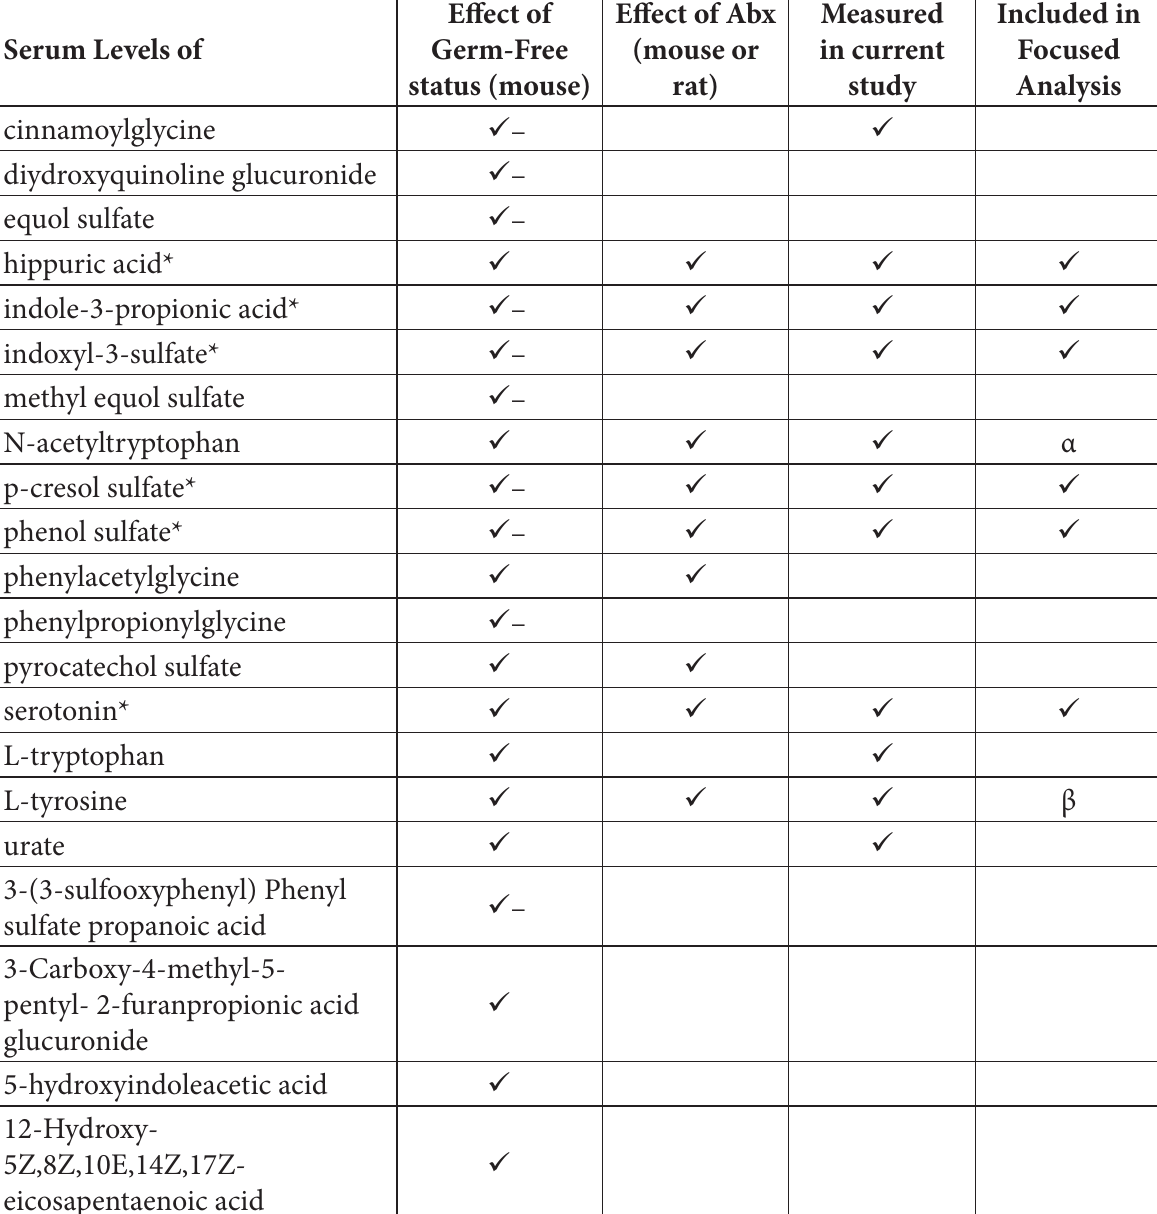
Effect of Effect of Abx Measured Included in Germ-Free (mouse or in current Focused status (mouse) rat) study Analysis